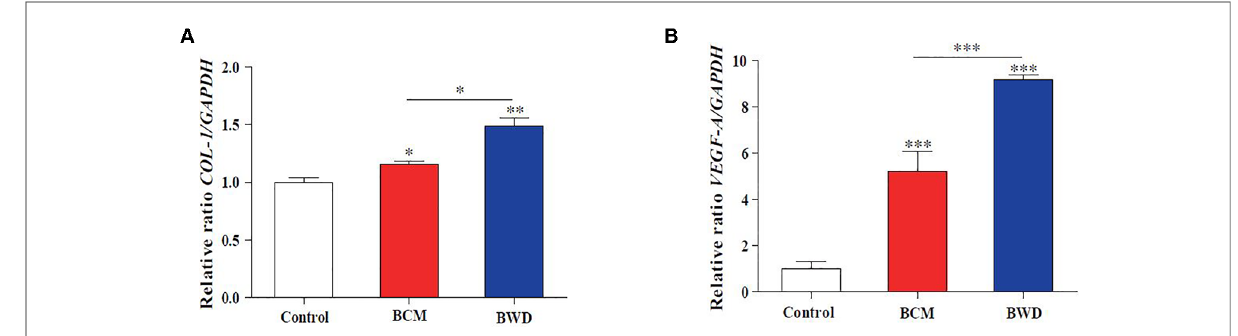
FIGURE 5 BWDs upregulate the expression of COL-1 and VEGF-A in vitro . ( A ) Expression of COL-1 in HDFs. ( B ) Expression of VEGF-A in HuVECs. Control, saline gauze; BCM, bacterial cellulose membrane; BWD, bioactive wound dressing; bar scales=100 μ M. Error bars represent SEM ( n =3), * P ≤ 0.05, ** P < 0.01, and *** P ≤